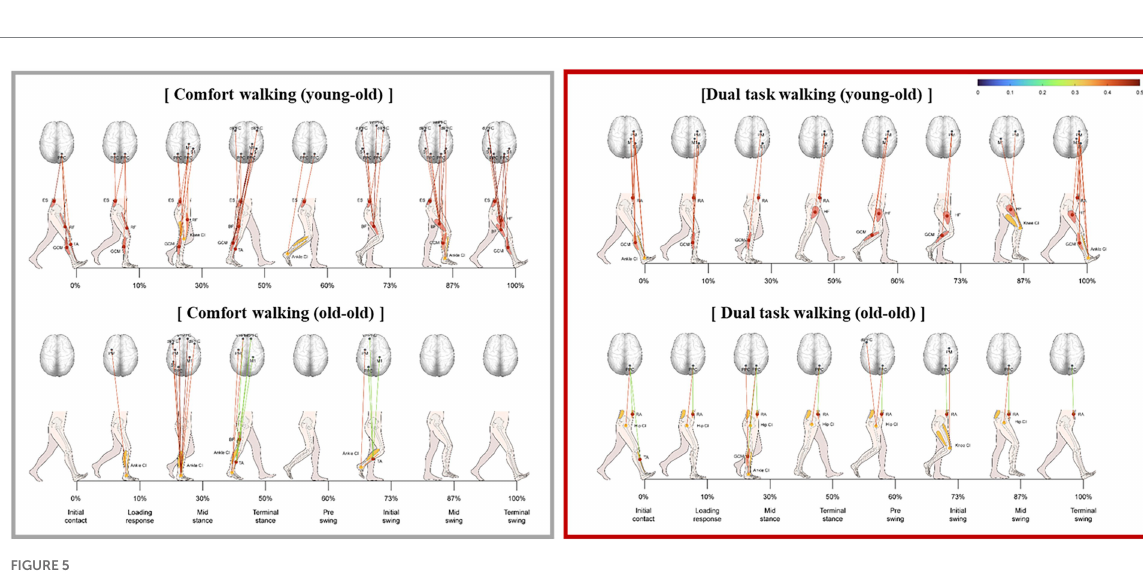
FIGURE 5 Significant correlation between lower limb muscle activity and cortical activation during cognitive dual-task walking in the young-old and old-old